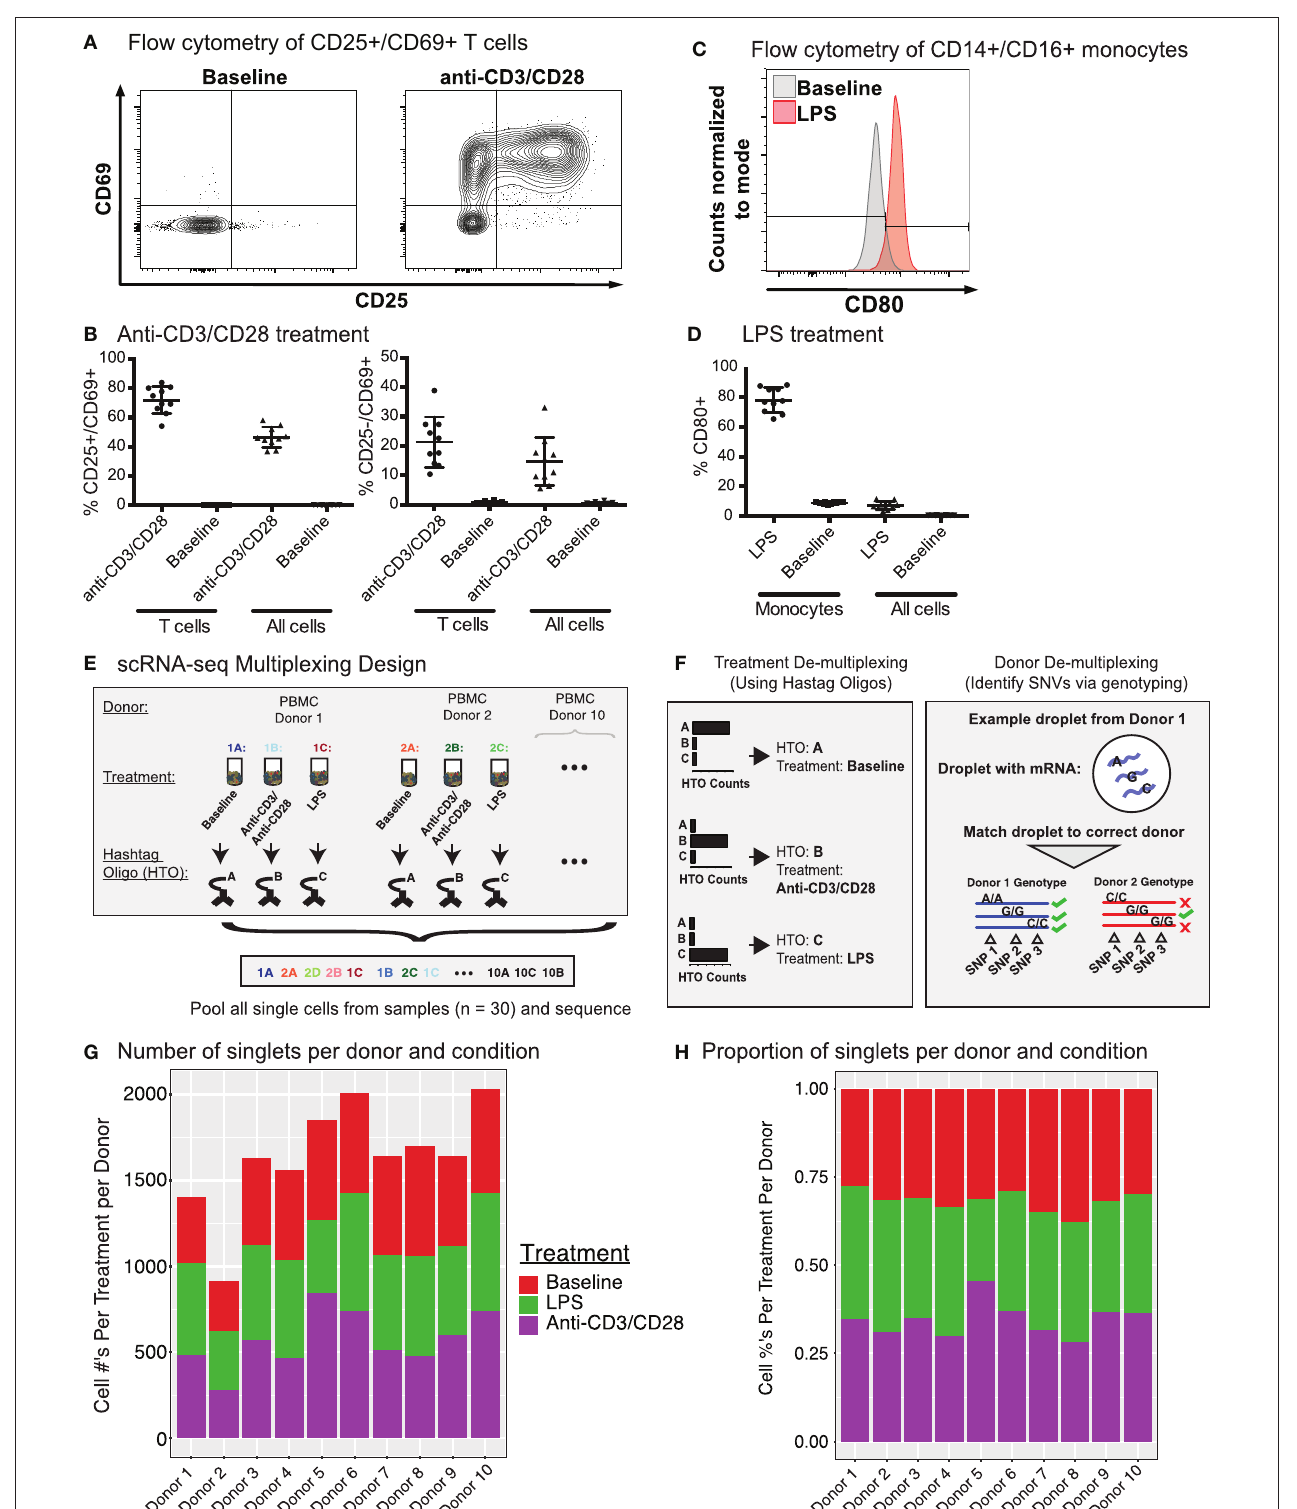
FIGURE 1 | CITE-seq data before and after immune cell activation uncover distinct cell types and cell states. (A) Fluorescence-activated cell sorting (FACS) and enrichment of activated T cells at baseline and anti-CD3/CD28 conditions. T cells were gated as CD3 + T cells. (B) Flow cytometry data quantifying the proportion